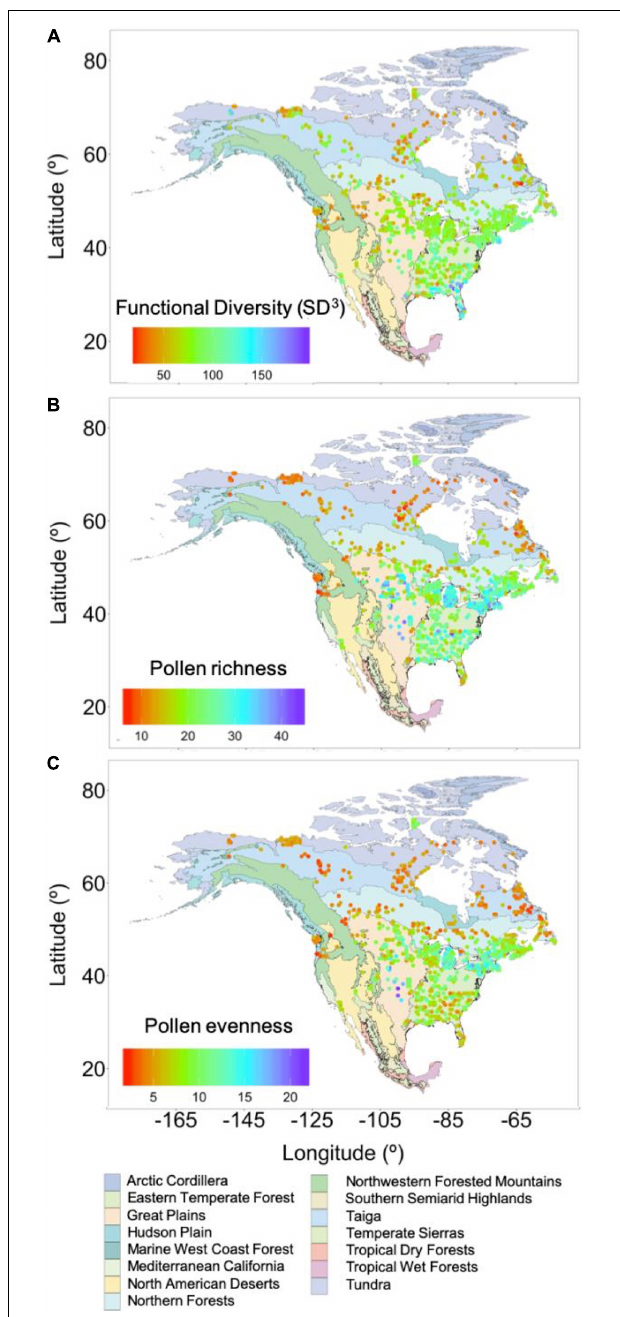
FIGURE 4 | Estimates of functional diversity (A) , pollen richness (B) , and pollen evenness (C) estimated from surface pollen samples presented as the mean values of all estimates within a grid cell plotted in relation to different ecoregions of North America (Omernik, 1987).